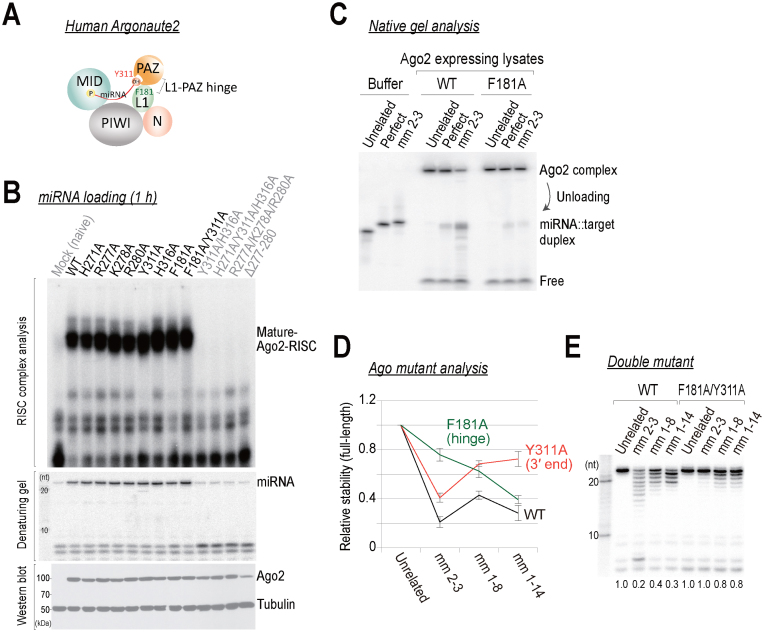
Identification and characterization of human Ago2 domains that are required for 3΄ end destabilization. (A) A schematic representation of human Ago2 domains. The miRNA is anchored at its ends in the PAZ and MID domains. (B) Top: miRNA duplexes containing radiolabeled guide strands were incubated in lysates expressing tagged wild-type or mutant Ago2 proteins at 37°C for 1 h. The RISC complexes were analyzed in a vertical agarose native gel at 4°C. Middle: miRNAs were analyzed in parallel by 15% denaturing-PAGE. Bottom: western blot analysis using an anti-FLAG antibody confirmed the expression of the tagged Ago2 mutant proteins. Anti-tubulin served as an internal control. (C) The F181A hinge mutation drastically inhibits miRNA release from the Ago2-complex. The samples were analyzed by 15% native-PAGE following the in vitro destabilization reactions in Ago2-expressing lysates or buffers. (D and E) The L1 and PAZ domains of human Ago2 are required for 3΄ end destabilization. Data are the mean ± SD for three independent experiments.